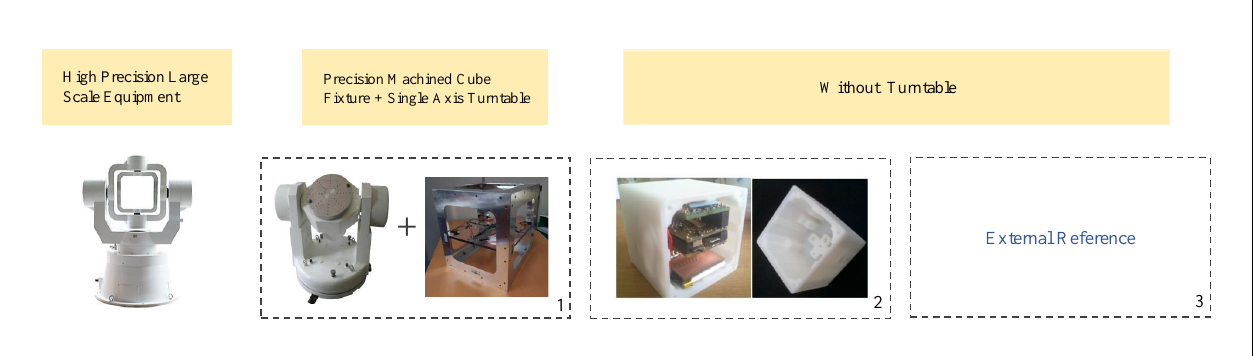
Figure 9. Some crucial existing calibration methods. Box 1 represents the combination of a low- precision turntable and cube fixture [66]; box 2 represents the tilt sensor with 3D-printed housing [22]; box 3 represents other autonomous calibration methods that do not require a